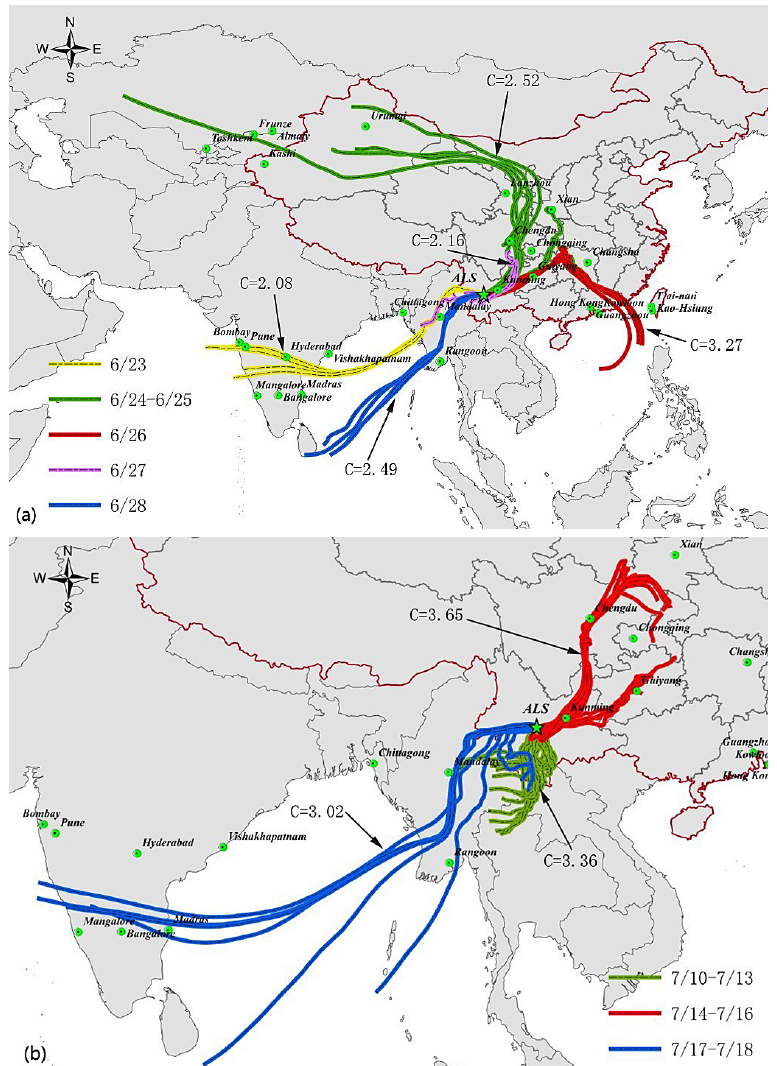
Figure 9. Backward trajectories of air masses and the variation of TGM concentrations because of the strengthening of and incursion of air flow from EASM on 23–28 June 2011 (a) , and 10–18 July 2011 (b) during the ISM period (May–September). The TGM levels (C) were 3.27ngm − 3 (a) and 3.65ngm − 3 (b) with the air masses from important industrial regions of inland China. The TGM levels were down to 2.49ngm − 3 (a) and 3.02ngm − 3 (b) while the air flow shifted to southwest and swept southeast